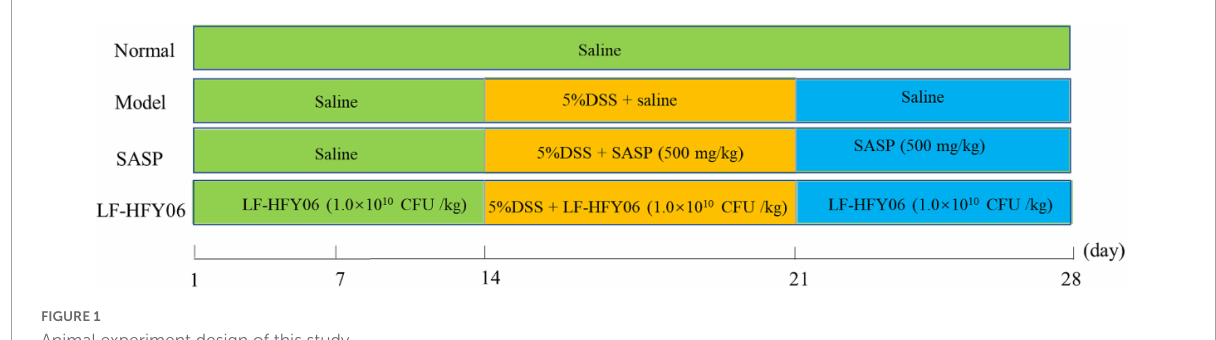
FIGURE1 Animal experiment design of this study.